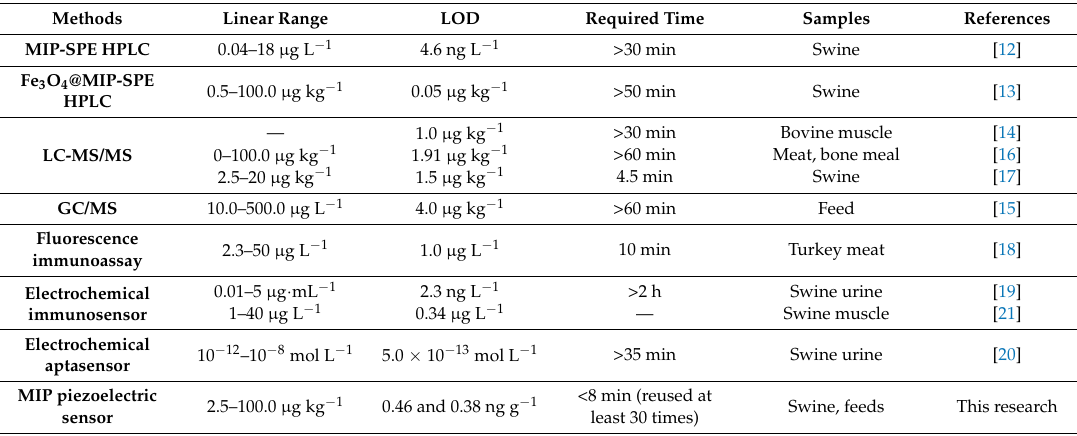
Table 2. Comparison of different methods for RAC determination in various